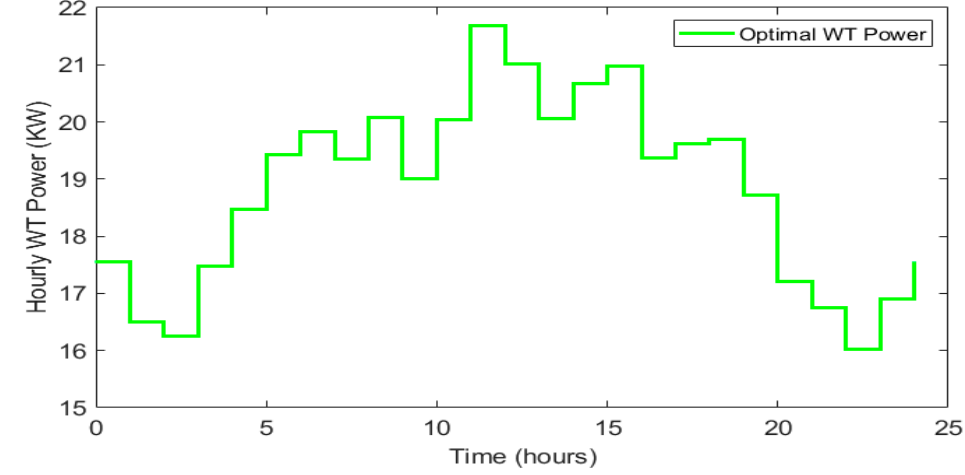
Figure 11. Optimal PV Generated Power. 3.5. Optimal Hourly Consumer Reduction Power The optimal hourly values of the power reduction of the two consumers of the system because of their participation in the Demand Response program are presented in Table 9 and in Figure 12 respectively. Essentially load shifting occurs because a customer defers his consumption to a different time period beyond the 24 h window that we examine. Within this window power reduction actually refers to load shedding. As a result of such shifting and load coverage at a different time consumers enjoy some financial reward, which results from some incentive tariffs. For example, the utility company may reward shifting load from off peak periods at a certain low rate (e.g., 10% off the normal price), shifting load from mid peak periods at a medium rate (e.g., 20% off the normal price) and shifting load from on peak periods at a high rate (e.g., 30% or more off the normal price).